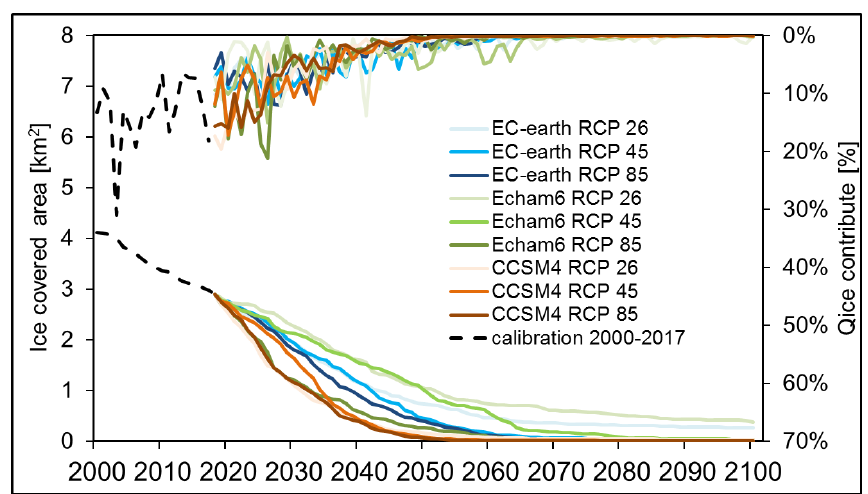
Figure 9. Sabbione catchment. Estimated mean monthly, and yearly mean discharge Q (m 3 s −1 ). Control Run (2005–2017) and projected for period P2 (2086–2100).